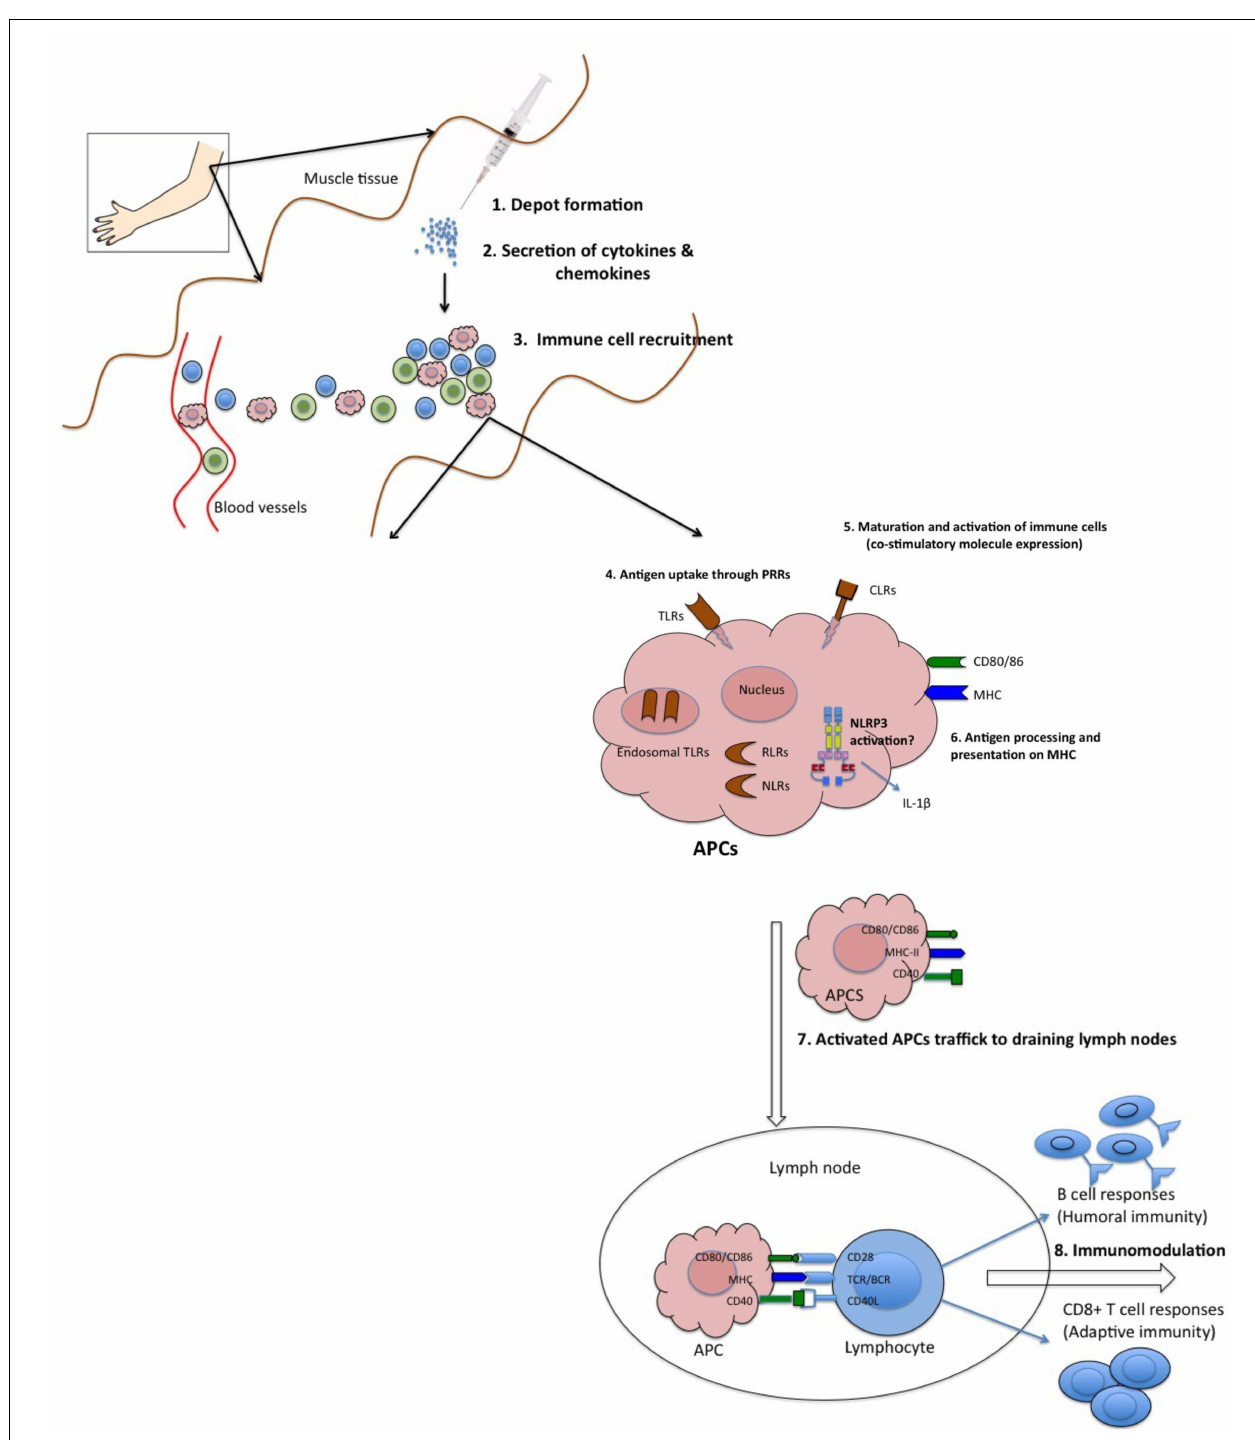
express various PRRs both on the surface (TLRs, CLRs) and intracellularly (NLRs and RLRs), which are recognized and/or are activated by the adjuvants. (5)This leads to maturation and activation of recruited APCs. Mature APCs up-regulate the expression of MHC and co-stimulatory molecules. (6)They are also characterized by increased capacity for antigen processing and presentation. (7) Mature APCs then migrate to the draining lymph nodes to interact with antigen-specific B orT cell to (8) activate potent antibody secreting B cells and/or effector CD8 + T cell